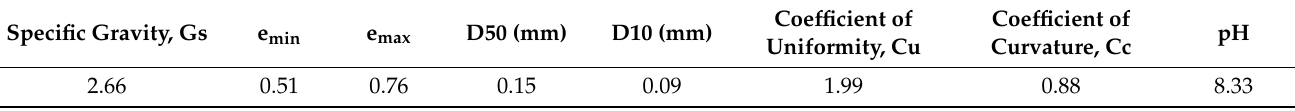
Table 1. Basic properties of the Thadiq